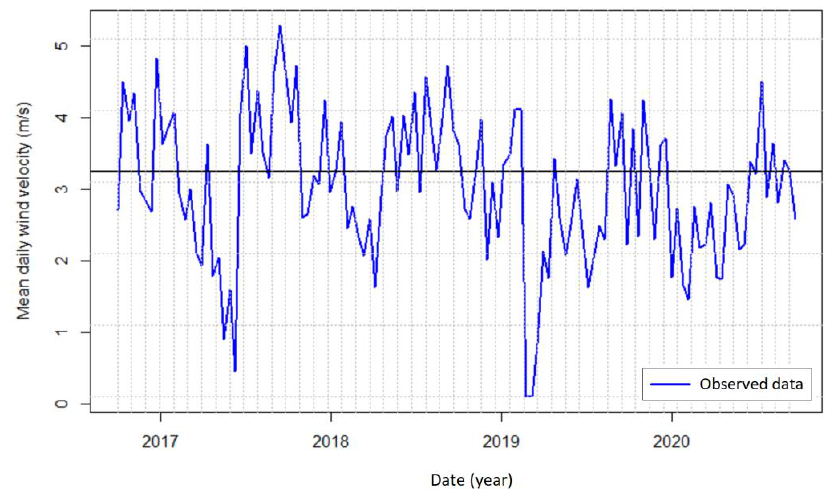
Figure 3. Mean daily wind velocity in SAR image dates. Source: INMET climatological station A349.